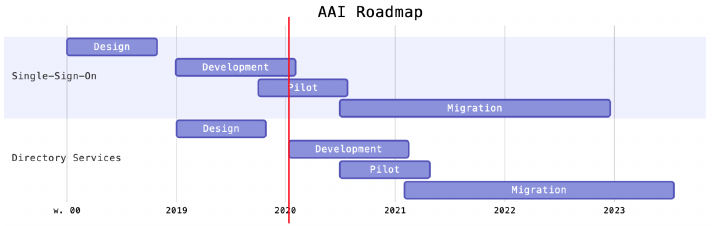
Figure 1. Expected timeline. Upper section describes Single-Sign-On, lower describes Directory Ser- vices (i.e.